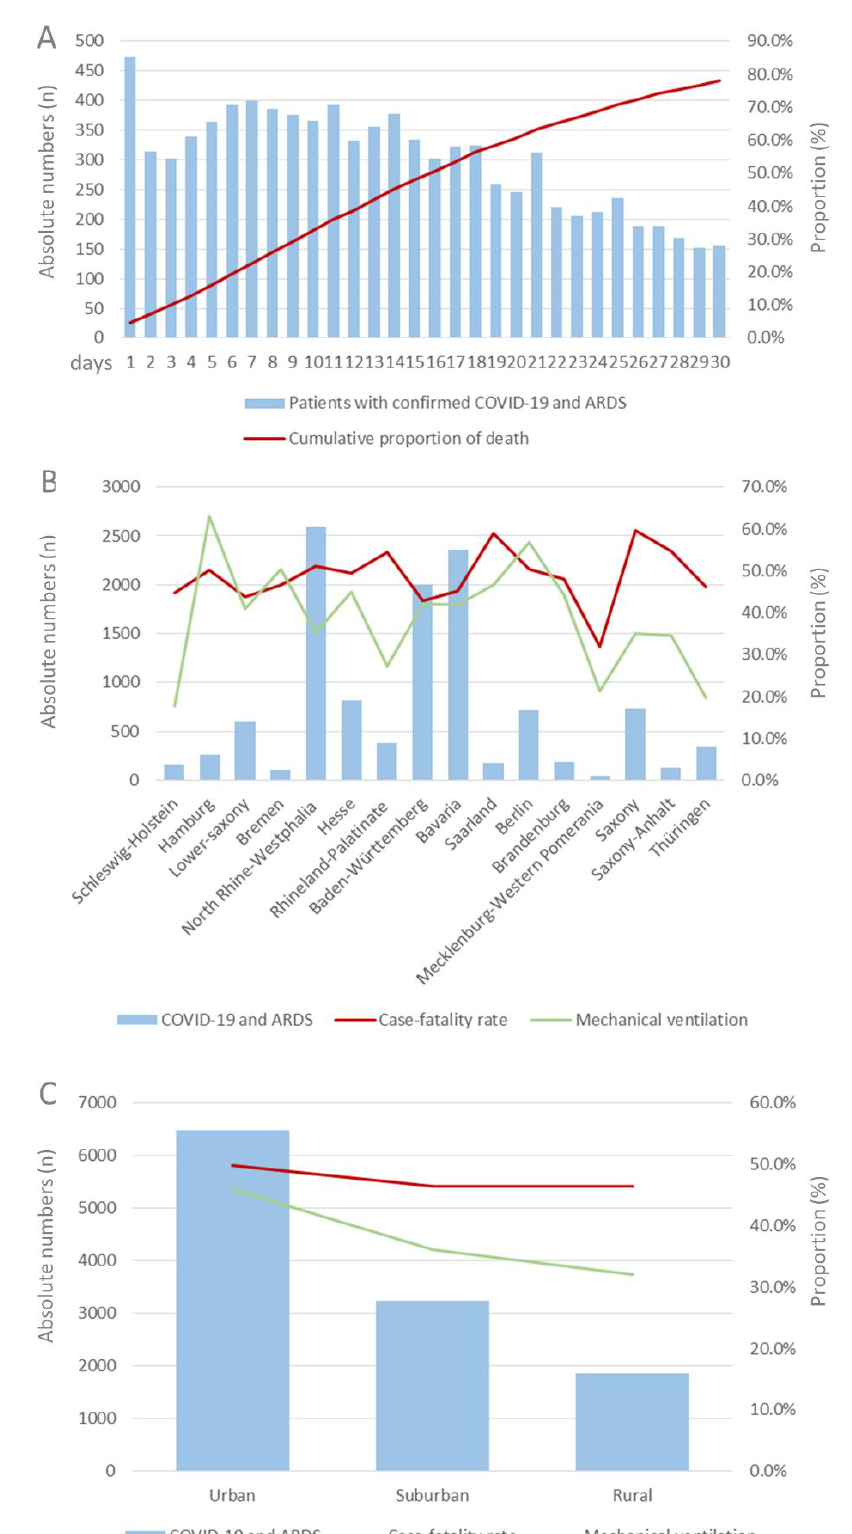
Figure 2. Cumulative proportion of deaths during in-hospital stay in patients with COVID-19 and ARDS ( A ), as well as trends regarding absolute numbers, case-fatality rates and mechanical ventilation, stratified for regions ( B ) and urban–rural ( C ) differences in Germany in 2020.